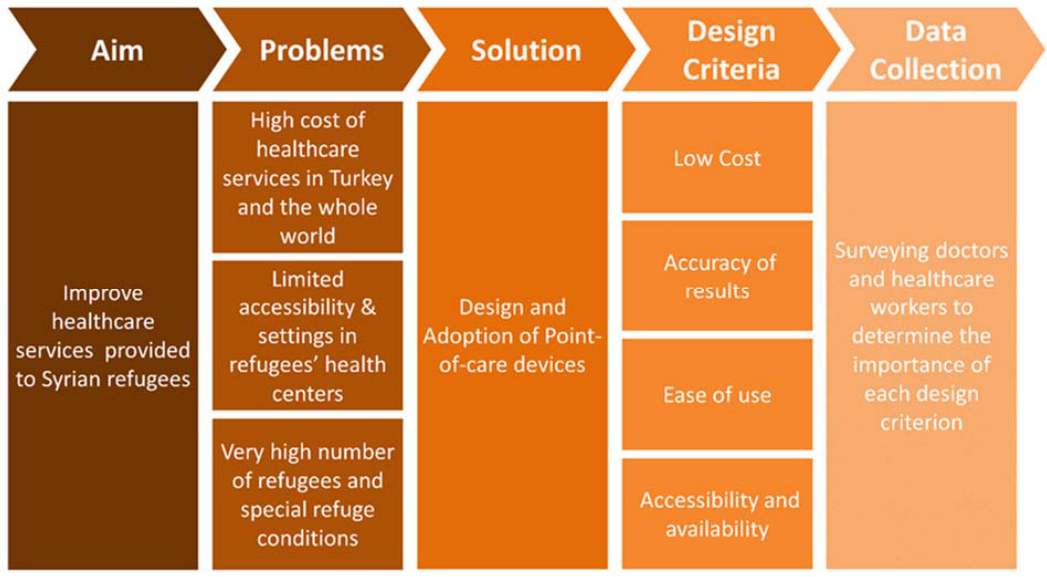
Figure 1. Overview of the workflow of the study.